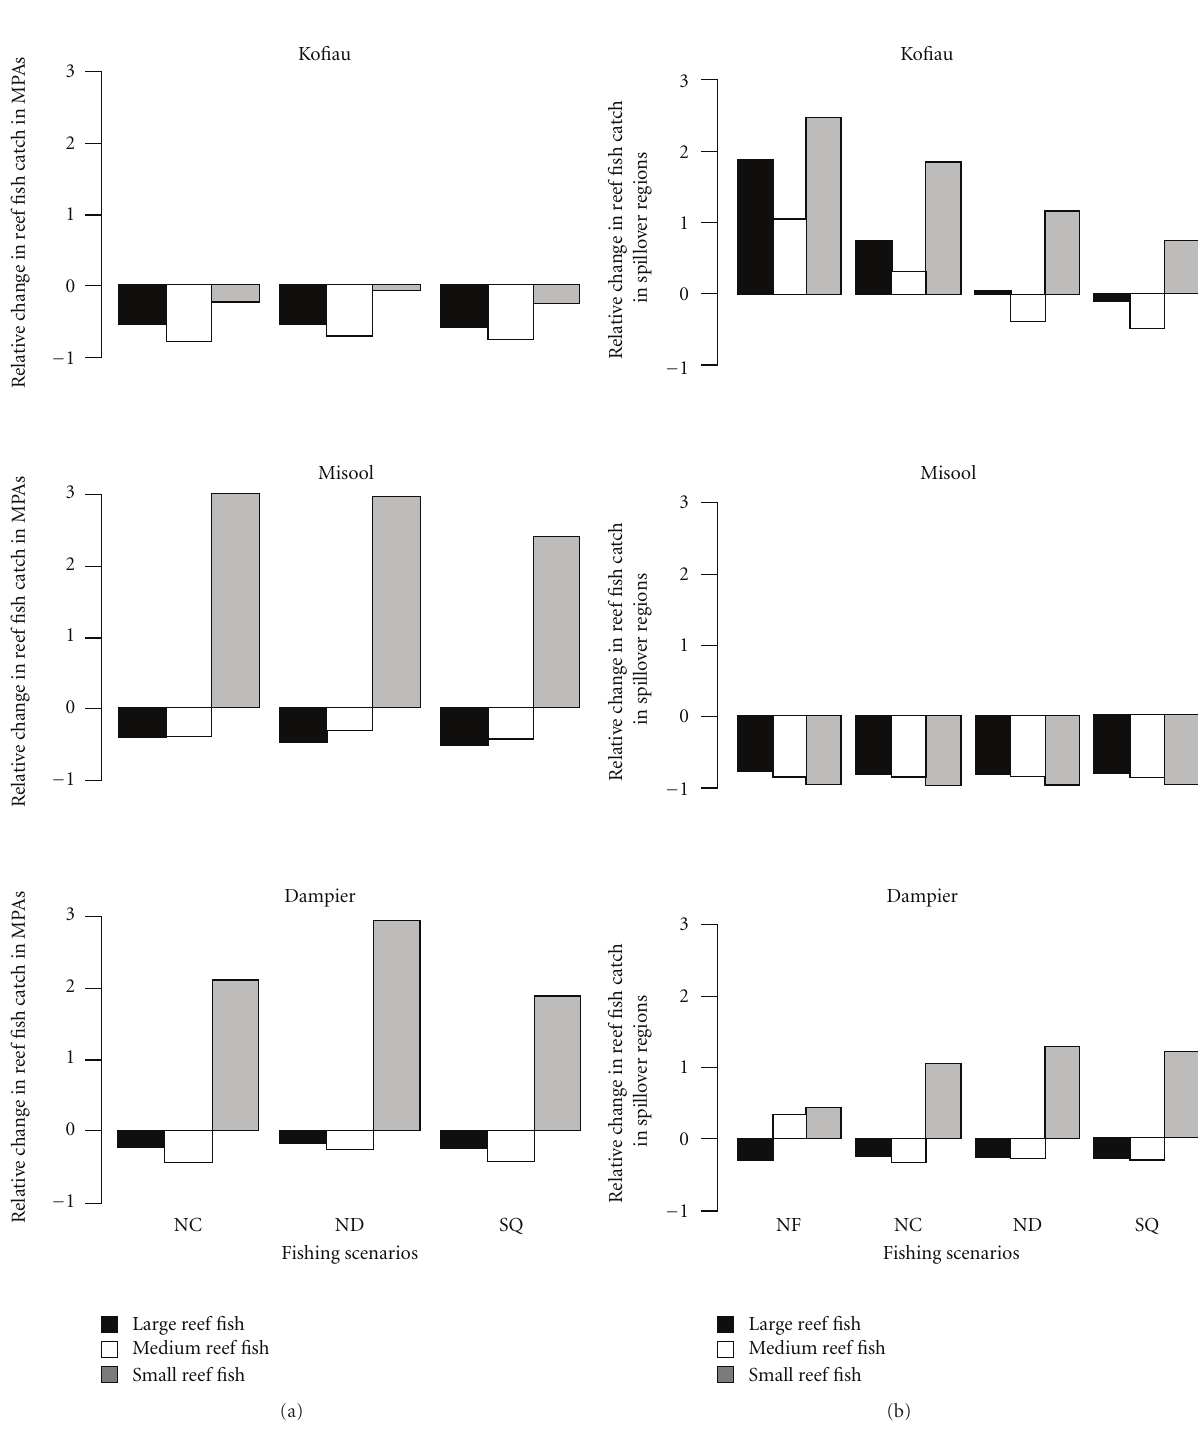
Figure 5: Relative catch changes inside the three analysed MPAs and spillover regions after 20-year simulation using Ecospace model. The bars show the change in catch relative to the base (model initialization for 2005) catch of large, medium, and small reef fish inside the MPAs (left panel) and spillover (right panel) under fishing restriction scenarios shown on horizontal axis: NF: no fishing, NC: no commercial fishing, ND: no destructive fishing, and SQ: status quo fishing. Black bars represent large reef fish, white bars represent medium reef fish, and grey bars represent small reef